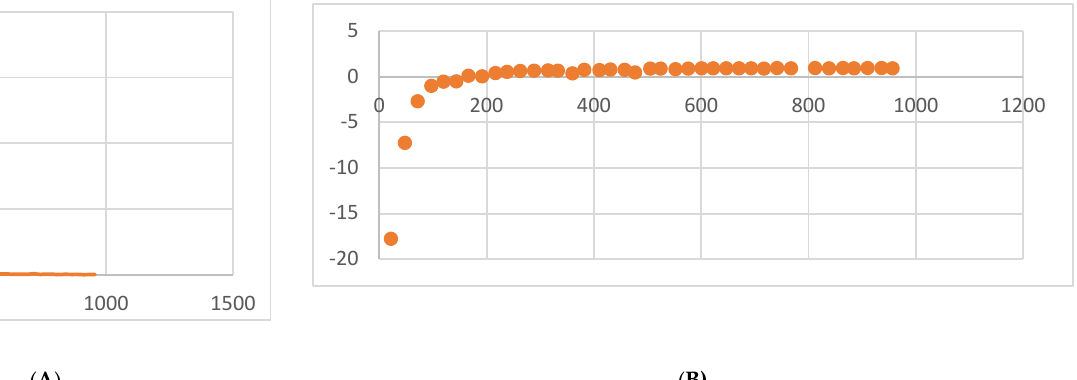
Figure 48. Left, ( A ) showing normalized concentration with respect to time for S100B, Figure 40 data, ( B ) showing a plateau in the concentration after 200 h of injury which is detectable indefinitely, (horizontal axis of 1000 h).